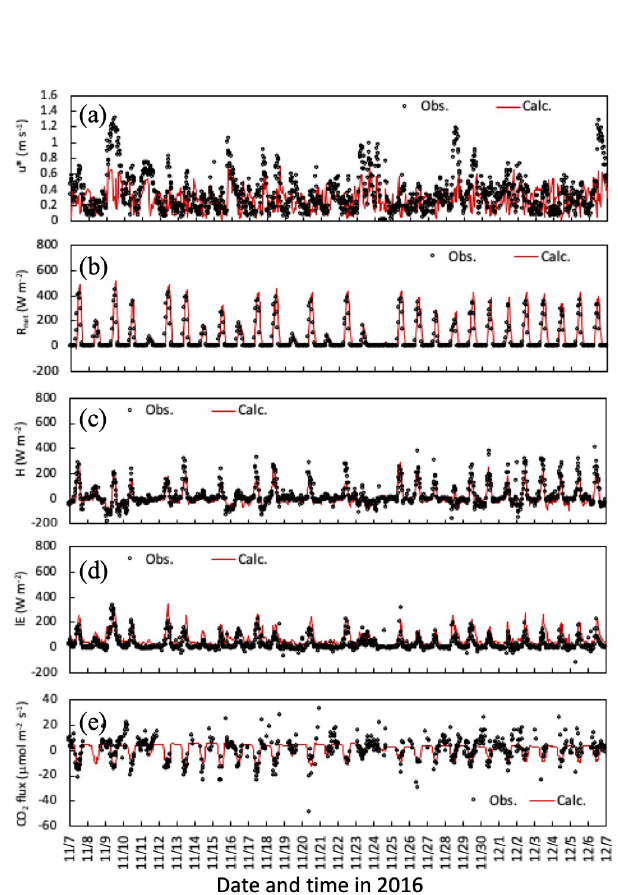
Figure 3. Temporal changes in observed and simulated (a) friction velocity, (b) net radiation, and (c) sensible and (d) latent heat, and (e) CO 2 fluxes from 7 November to 6 December 2016. Please note that the date is given on the x axis in the month/day